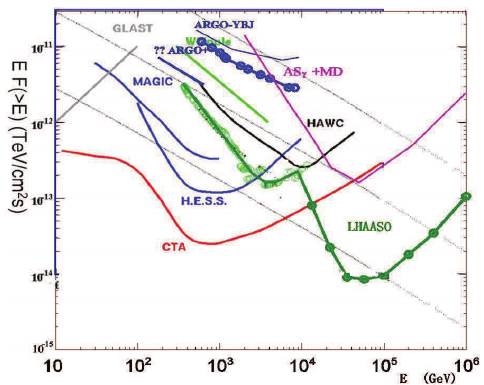
Figure 8: The sensitivity of LHAASO-WCDA + LHAASO-KM2A (green line) compared to other exper- iments or projects. The observation times is 1 year and 50 hour for wide field-of-view detectors and IACT, re-